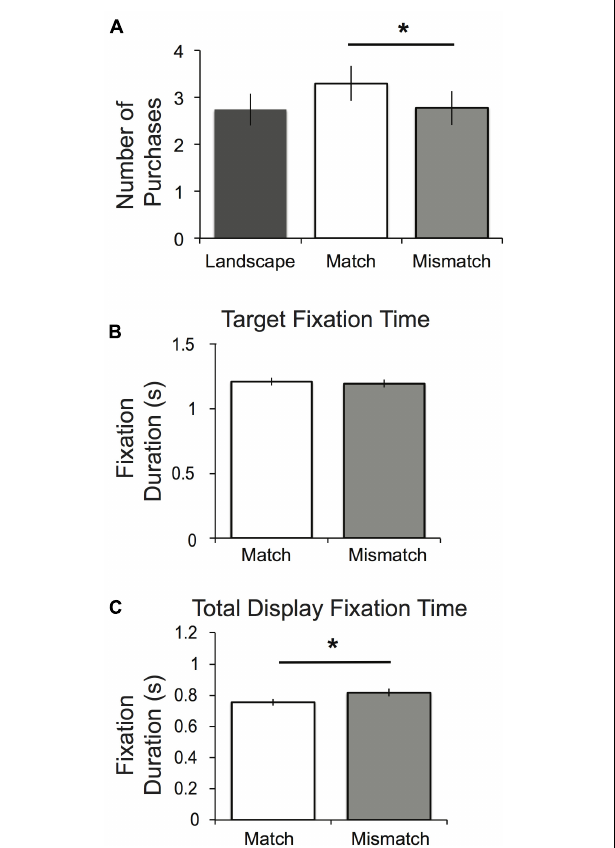
FIGURE 2 | Study 1 results. (A) Number of purchases (incentive compatible “yes” decisions) made in each experimental condition. (B) Average of the total fixation time spent on the target image per trial in the matched ( M = 1.21, SE = 0.0301) and mismatched ( M = 1.19, SE = 0.0312) conditions.